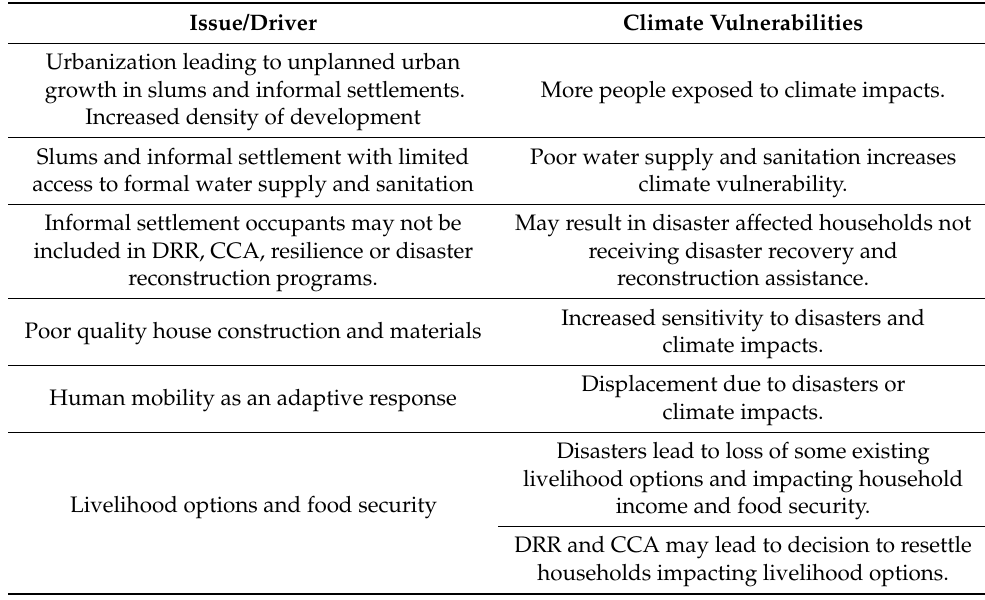
Table 2. Major issues and drivers impacting climate vulnerability.